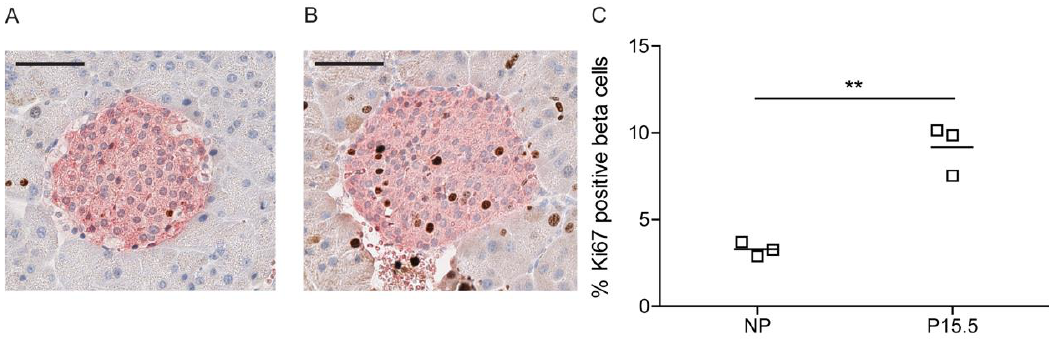
Figure 6. Pregnancy induces a normal level of beta cell proliferation in 129P2/OlaHsd mice. Representative immunohistochemical staining of a pancreatic islet of a NP ( A ) and a P15.5 ( B ) 129P2/OlaHsd mouse. The nuclei of the pancreatic cells were stained with haematoxylin (blue) and for the proliferation marker Ki67 (brown). Insulin-positive beta cells are labeled pink. Scale bar 50 µm. ( C ): Quantification of beta cell proliferation (% Ki67 positive beta cells) in NP and P15.5 129P2/OlaHsd mice. Significance of differences between non-pregnant and pregnant mice was calculated using the unpaired Student’s - t test ** p < 0.01, n = 3 for each group.